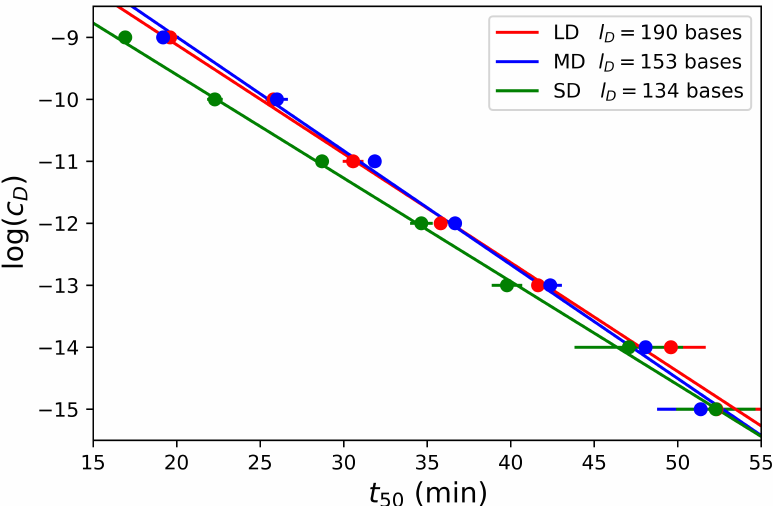
Figure 5. Dumbbell concentrations in logarithmic scale as function of time t 50 for various concentra- tions of dumbbells from 1 nM to 1 fM and for the three different dumbbell